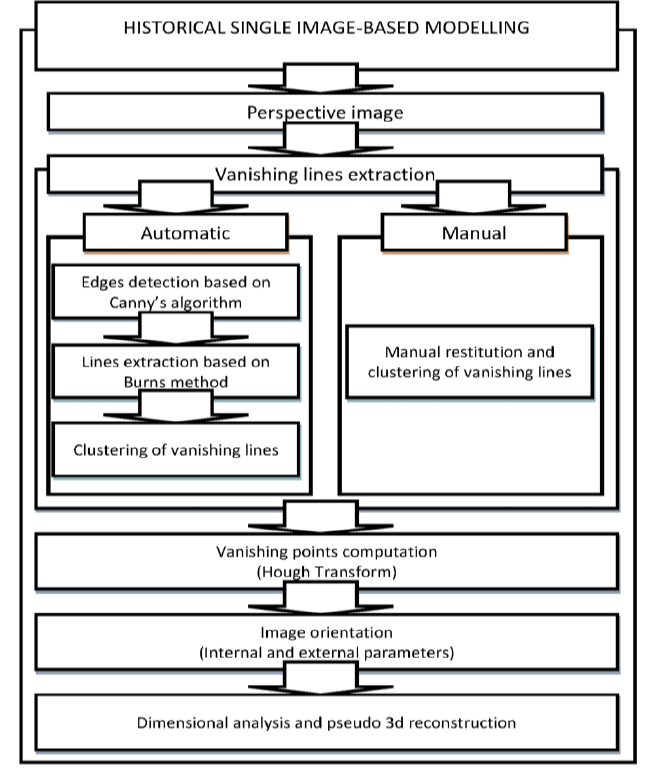
Figure 4. Workflow developed for the historical single image-based modeling applied to the case study of the “Gobierna